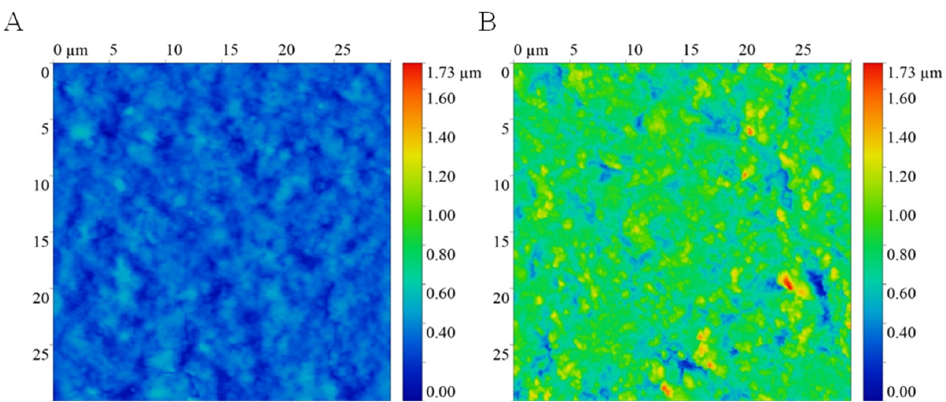
Figure 1. Atomic force microscopy micrographs of ( A ) uncoated and ( B ) AgNPs-coated urinary catheters.